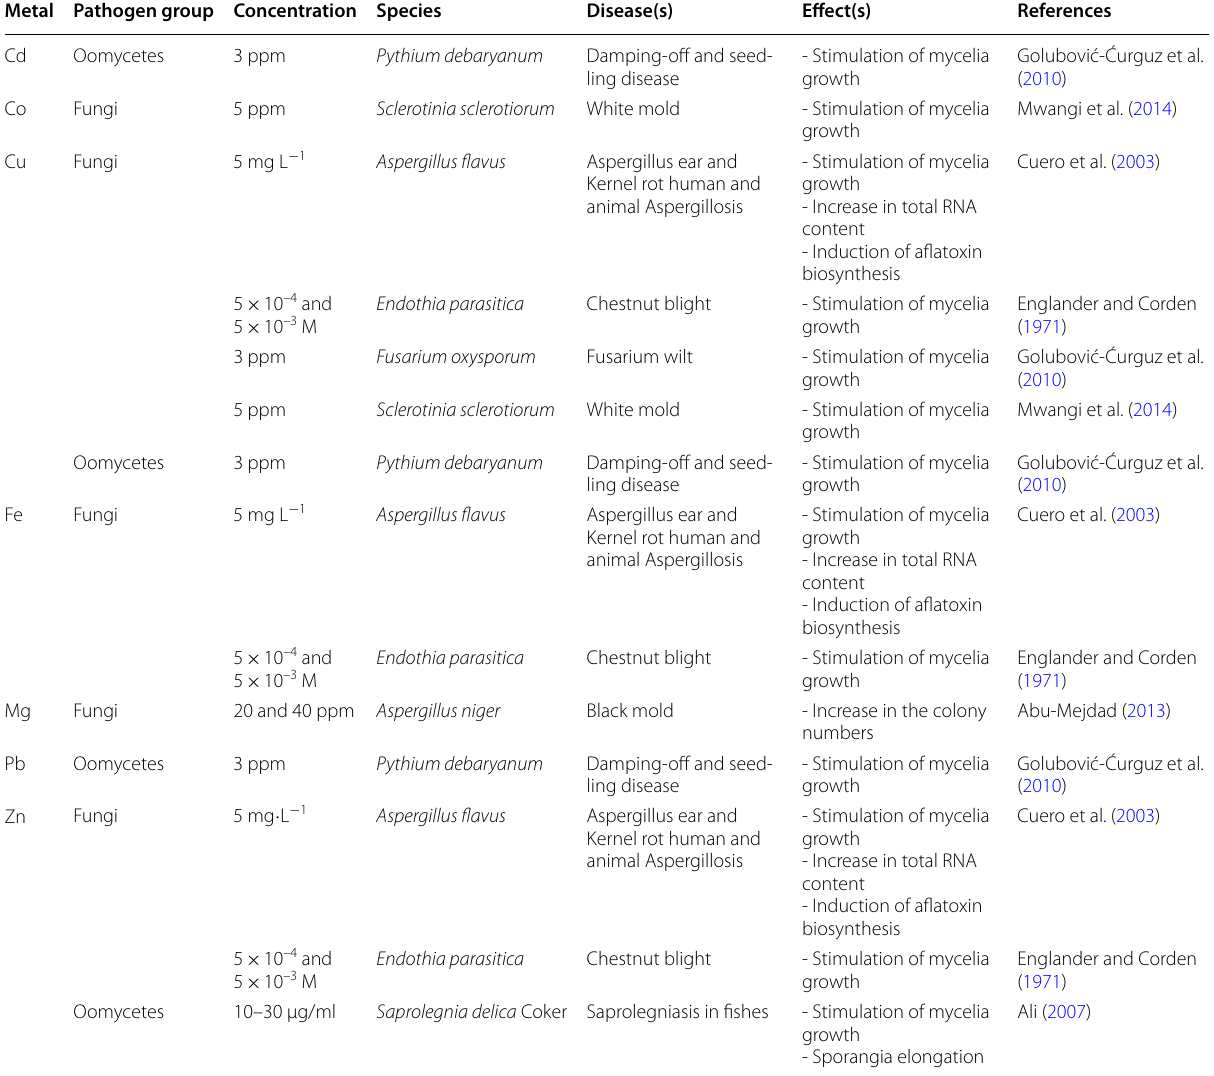
Table 2 The hormetic effect of HMs on filamentous pathogens Metal Pathogen group Concentration